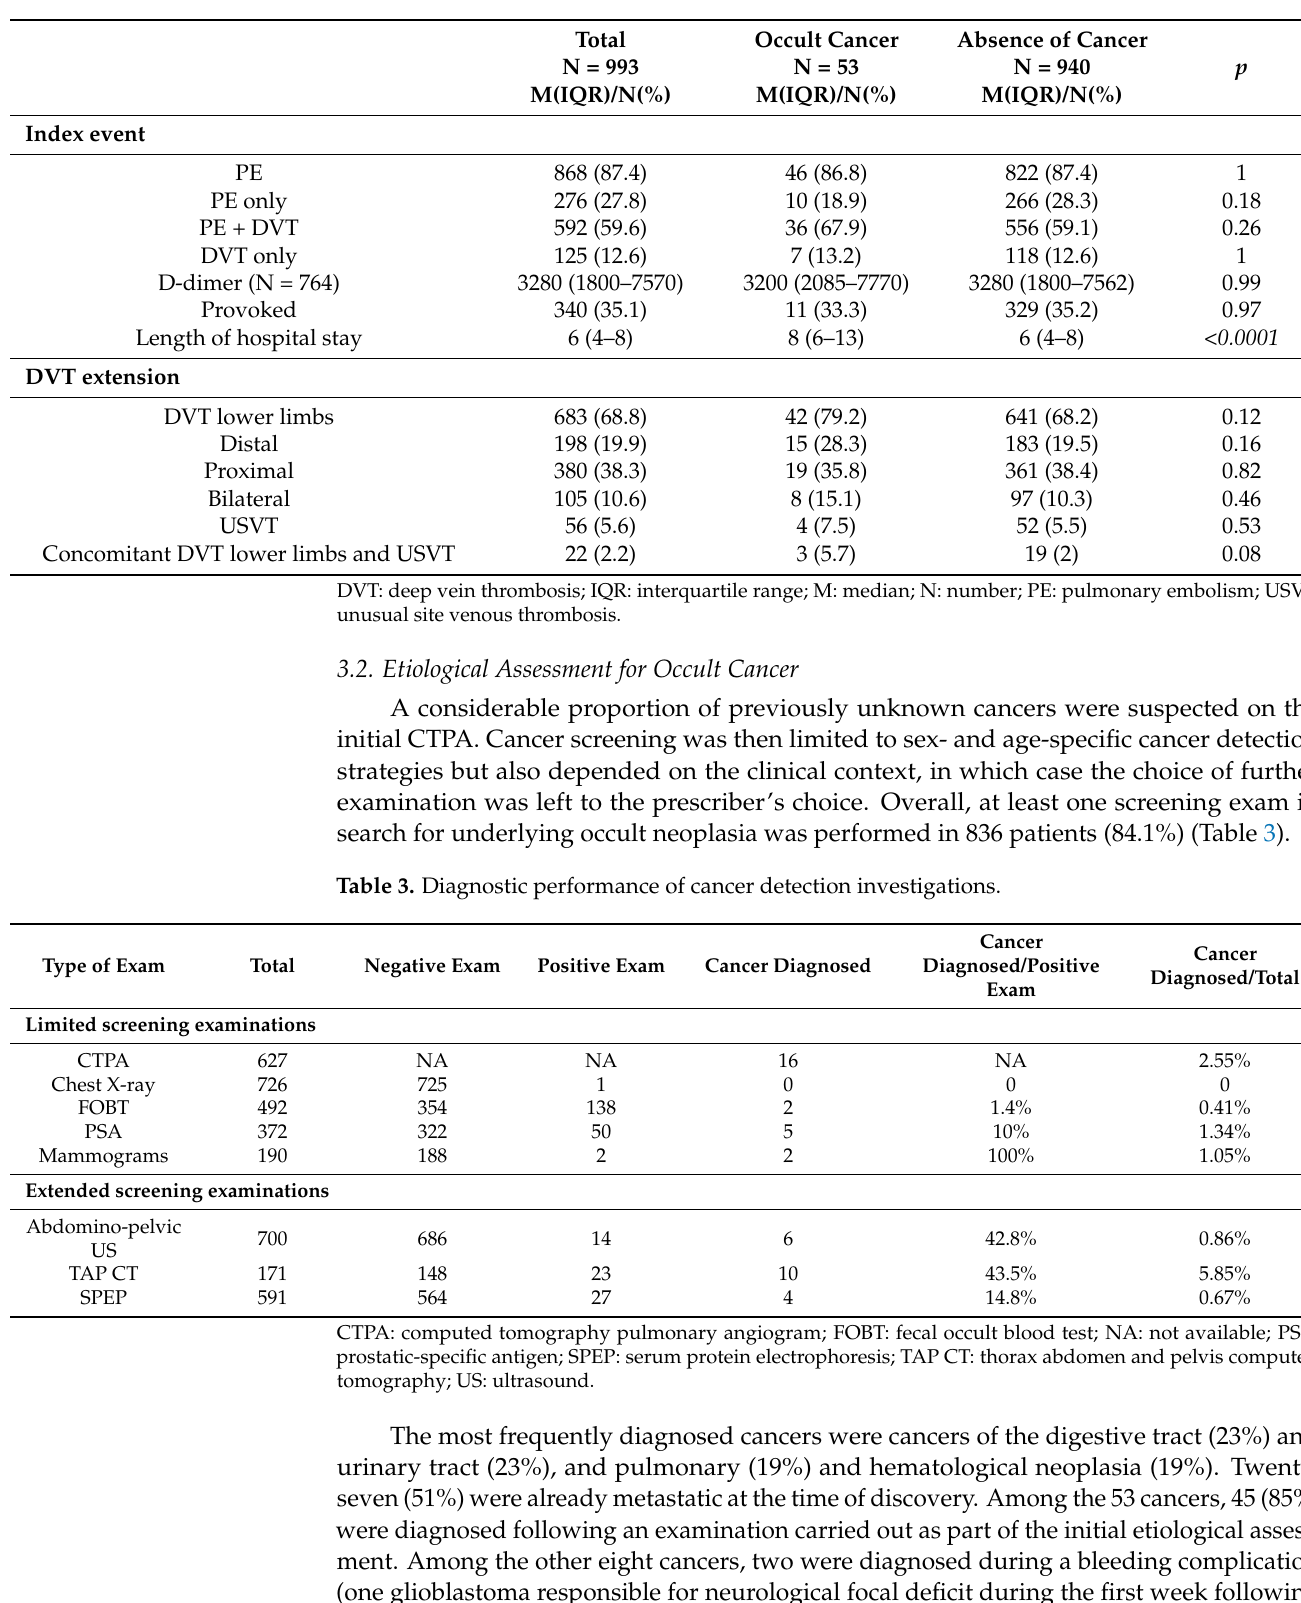
Table 2. Characteristics of the VTE index